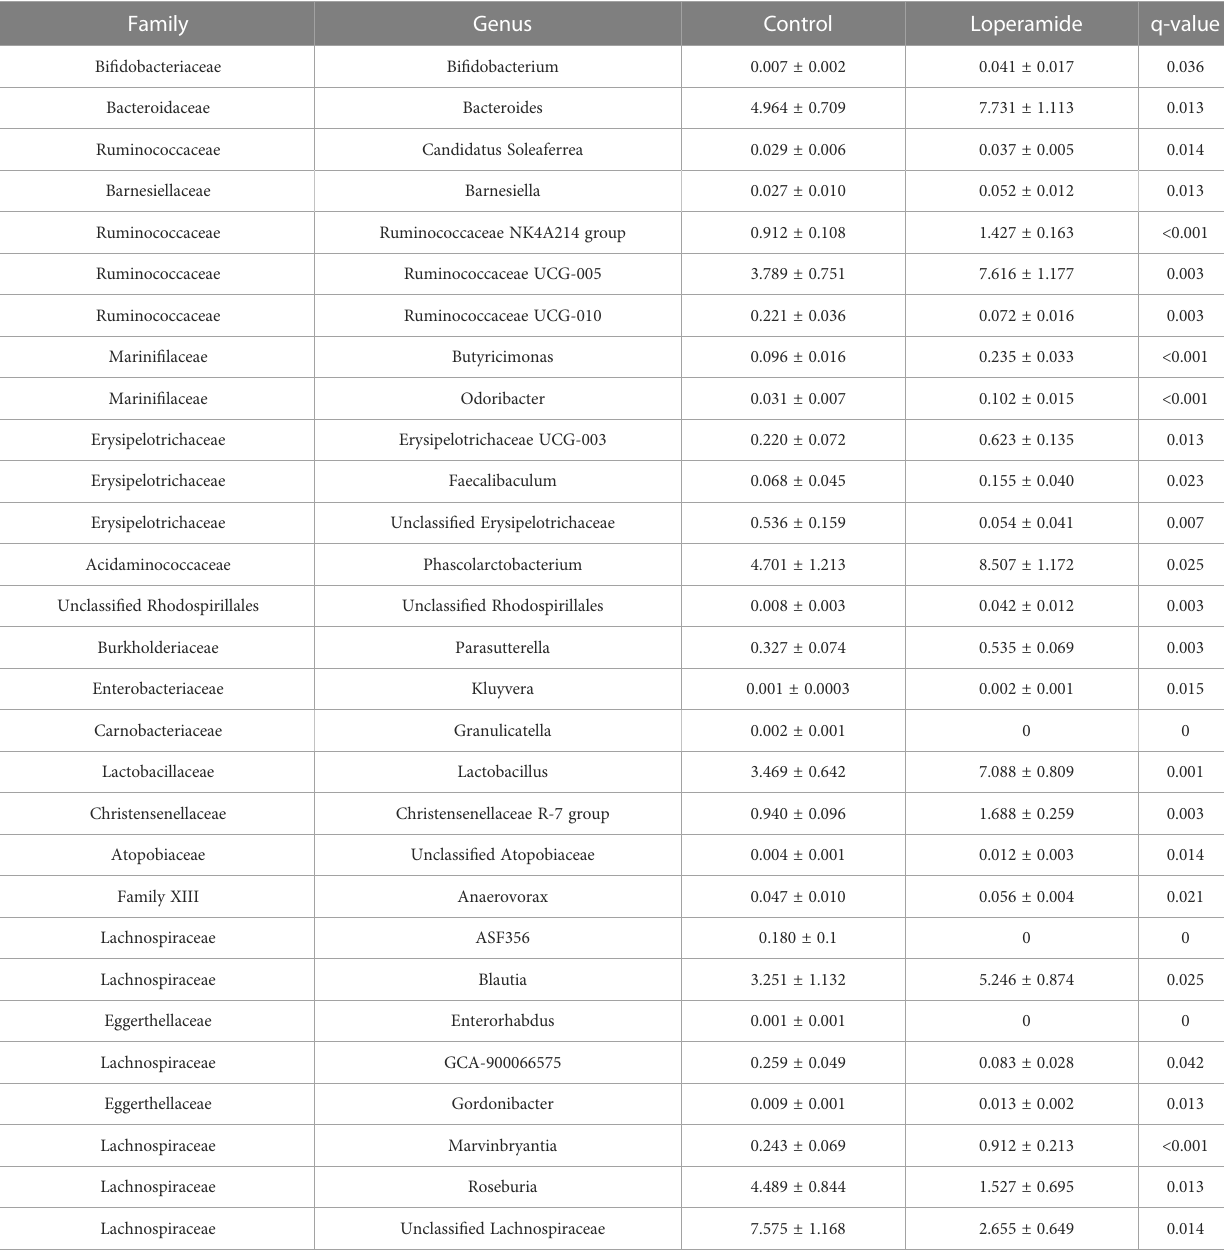
TABLE 2 Genera with signi fi cantly different relative abundances between loperamide- treated and control rats. Data represented as mean percent ± standard error of mean